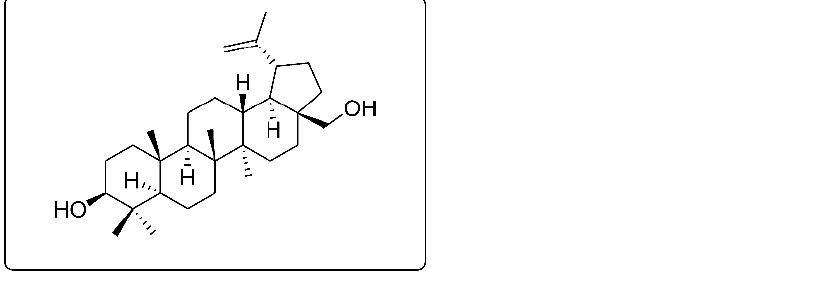
Figure 1. Chemical structure of betulin (3-lup-20(29)-ene-3 β ,28-diol, molecular weight = 442.72 g/mol). As triterpenoids have already been shown to inhibit protein kinases, we tested the inhibitory effect of betulin on a panel of protein kinases (PKs). Eight disease-related human PKs were tested including cyclin-dependent kinases (CDK5/p25 and CDK9/CyclinT), Haspin, proto-oncogene proviral integration site for moloney murine leukemia virus-1 (Pim1), glycogen synthase kinase-3 beta (GSK-3 β ), casein kinase 1 epsilon (CK1 ε ), Janus kinase 3 (JAK3), and Abelson murine leukemia viral oncogene homolog 1 (ABL1). Table 1 shows the results of the primary screening. Betulin showed weak activity against Pim1; i.e., at 10 µ g/mL, it showed only 10% inhibition of kinase activity. This contrasted markedly with ABL1, whose kinase activity was inhibited by 79%. JAK3 and GSK-3 β also showed inhibition by betulin. Table 1. Primary screening of betulin purified from Acacia auriculiformis against a panel of eight disease-related human protein kinases. Betulin 1 Tested at: 1 Data in the Table represent the % of kinase activity that remained following treatment of each kinase with 10 or 1 µ g/mL of betulin, normalized to control (that is, kinase activity in the presence of the vehicle, DMSO, only). ATP concentration used in the kinase assays was 10 µ M, and values given represent mean (n = 2). A value ≥ 100 indicates that the compound does not detectably inhibit the enzymatic activity at the tested